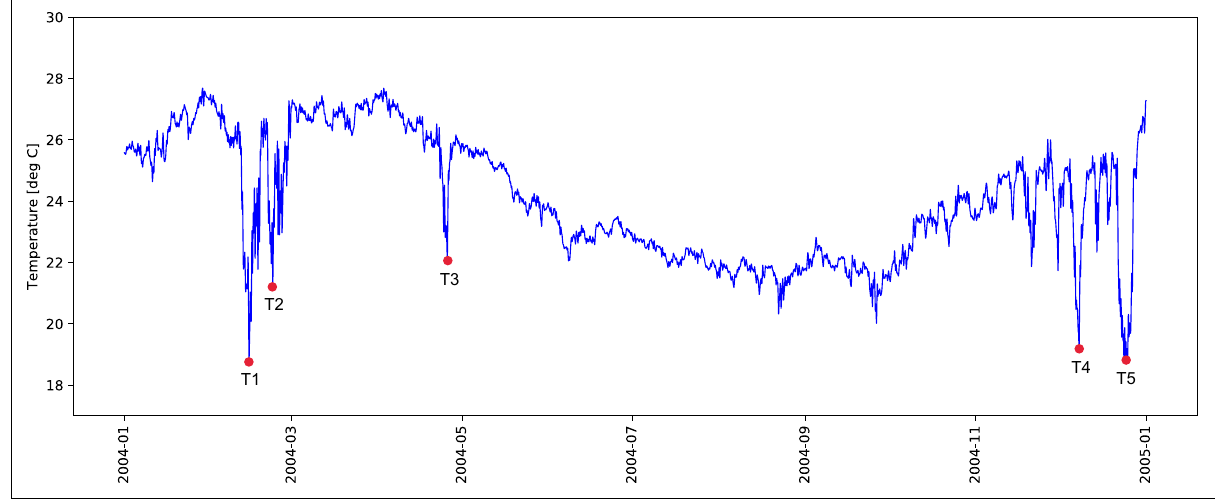
Figure 2: Time series of measured hourly temperature at Nine-Mile Reef during 2004. The individual temperature anomaly peaks are indicated by red dots.